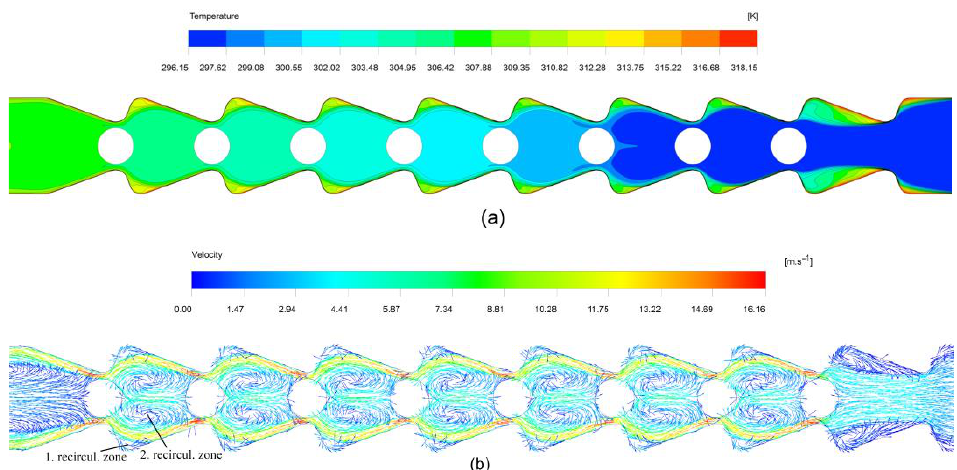
Figure 10. The temperature fields and velocity vectors of the WCCB15 for Q = 50 m 3 /h and CVGs position ‘1’, ( a ) temperature fields along the channel, ( b ) velocity vectors along the channel.